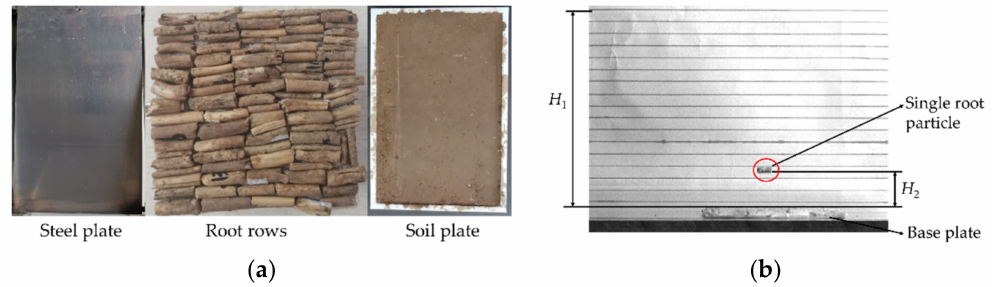
Figure 6. Measurement of restitution coefficient e between SMR and different materials. ( a ) Base plate with steel, root, and soil; and ( b ) the freefalling and bouncing process of